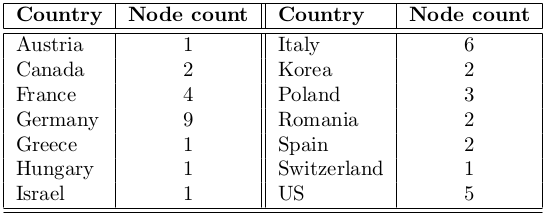
Table from the paper: End-Host Distribution in Application-Layer Multicast: Main Issues and Solutions
Table text:
Country
Nodecount
Country
Nodecount
Austria
1
Italy
6
Canada
2
Korea
2
France
4
Poland
3
Germany
9
Romania
2
Greece
1
Spain
2
Hungary
1
Switzerland
1
Israel
1
US
5